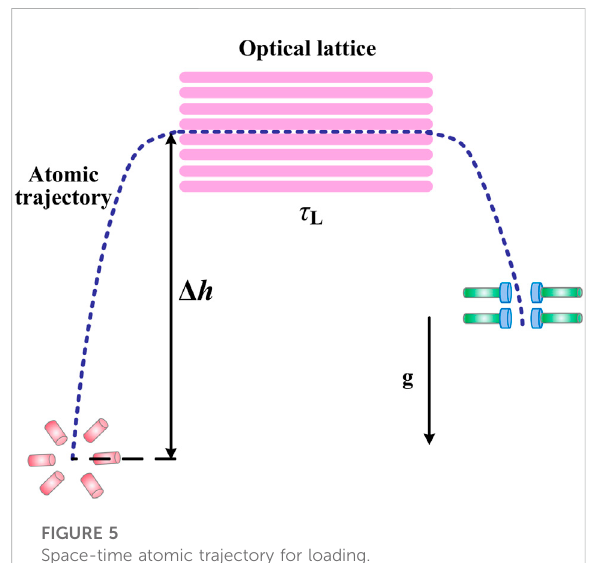
FIGURE 5 Space-time atomic trajectory for